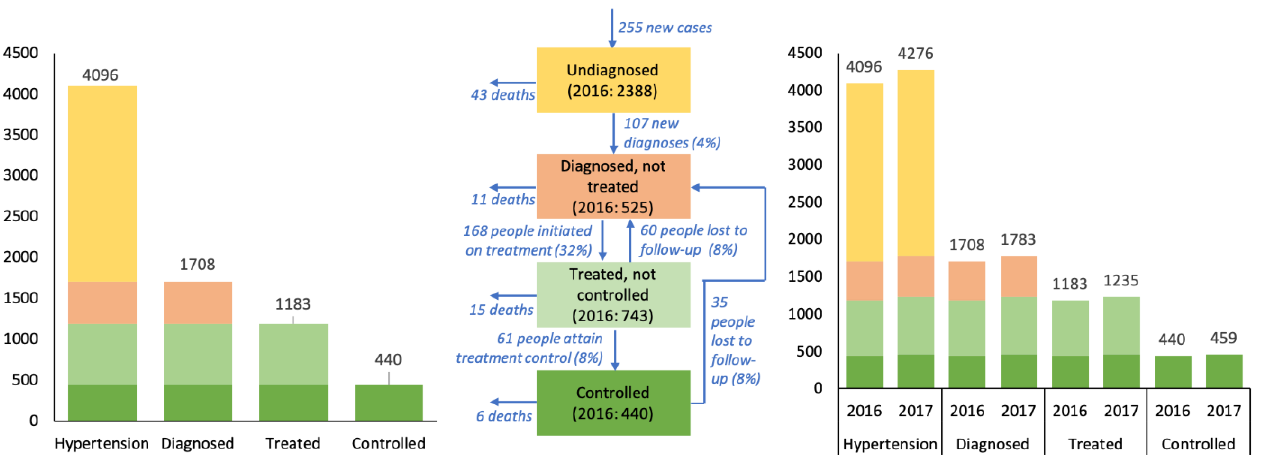
Figure 5. (Panel A) Input data on the state of the hypertension cascade; (Panel b) Illustrative hypertension cascade model with flow rates described in blue text; (Panel C) Cascade representation of the hypertension model with the 2016 values as per the input data and the 2017 values derived from applying the flow rates in Panel